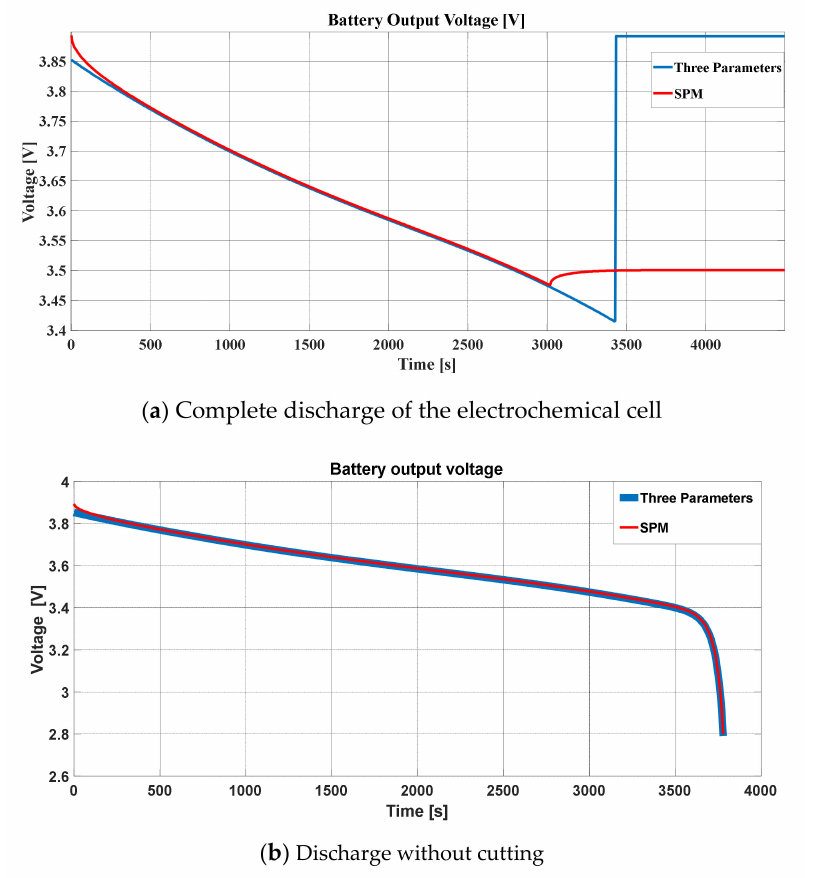
Figure 13. Comparison of the output voltages of both models after a discharge at 1C: ( a ) complete discharge of the electrochemical cell; ( b ) discharge without